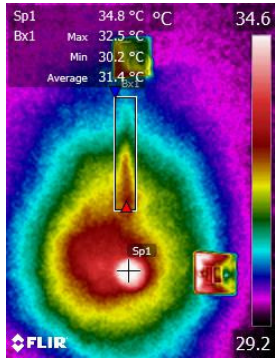
Figure 11. Thermogram of the hidden junction box.